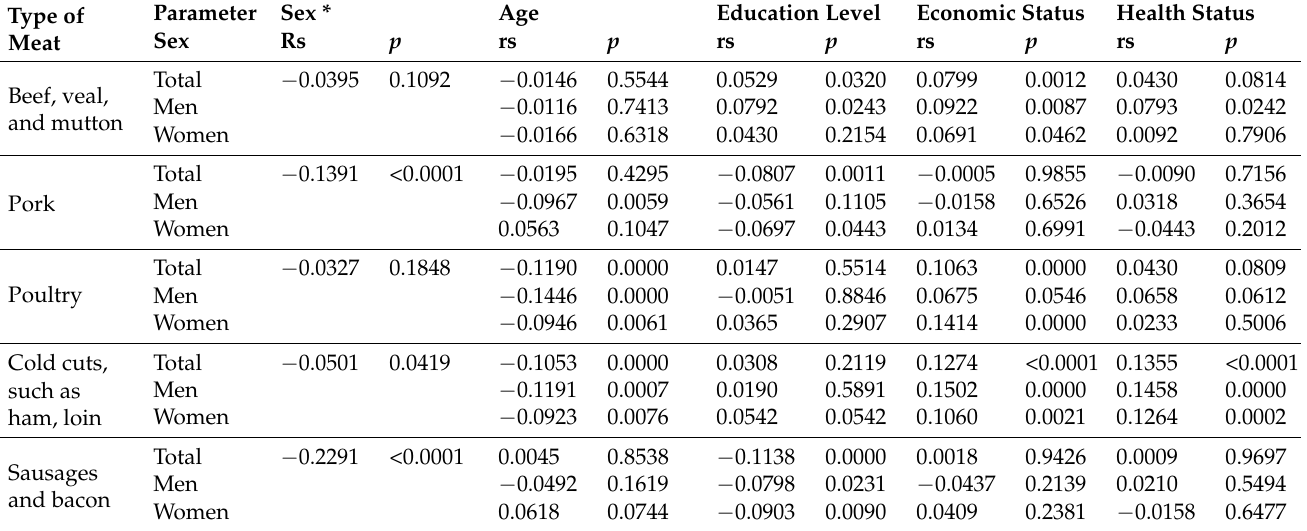
Table 4. Relationships between socio-demographic characteristics and the frequency of consumption of selected types of meat and meat